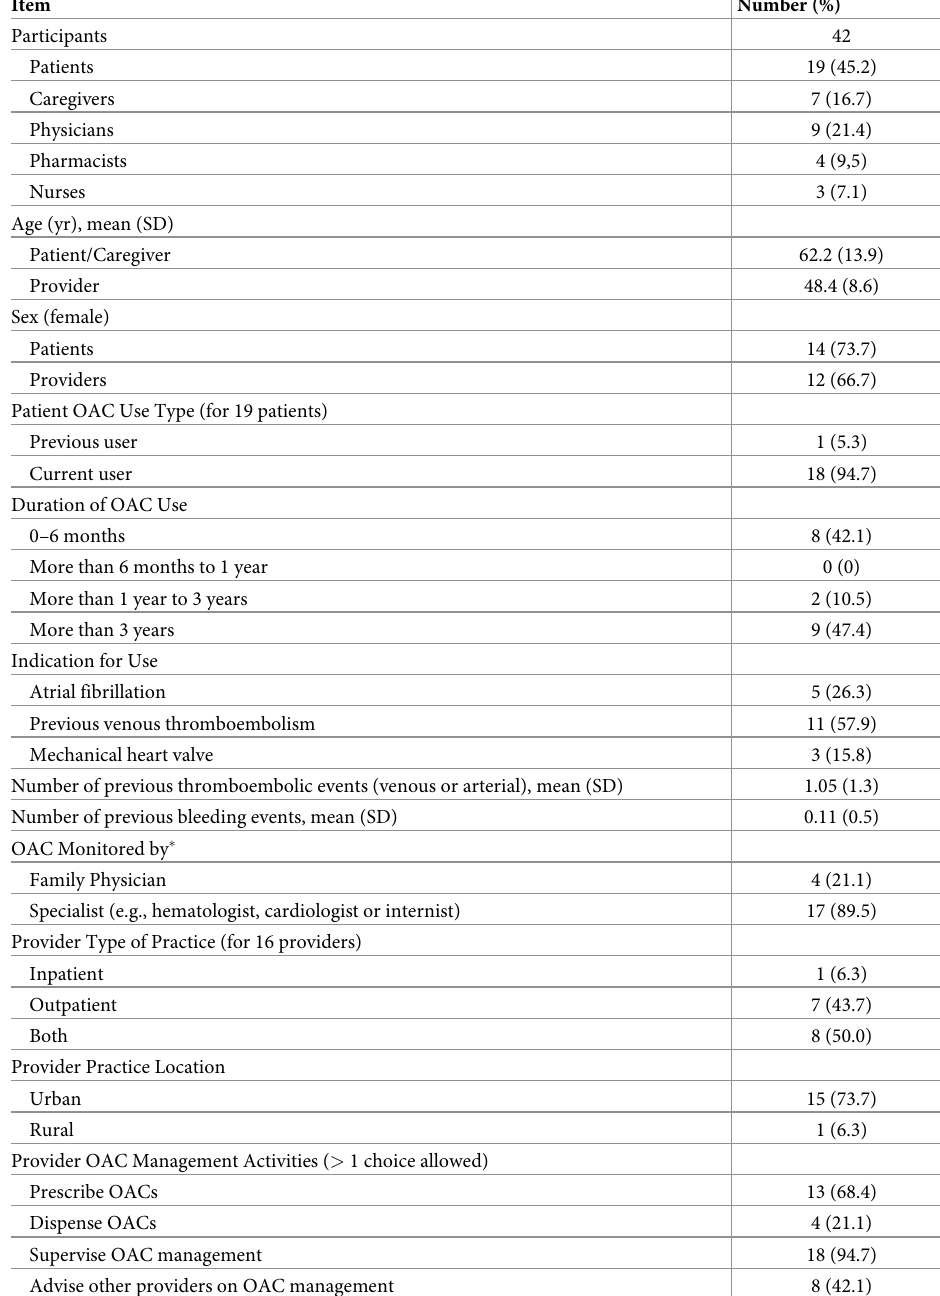
Table 1. Participant